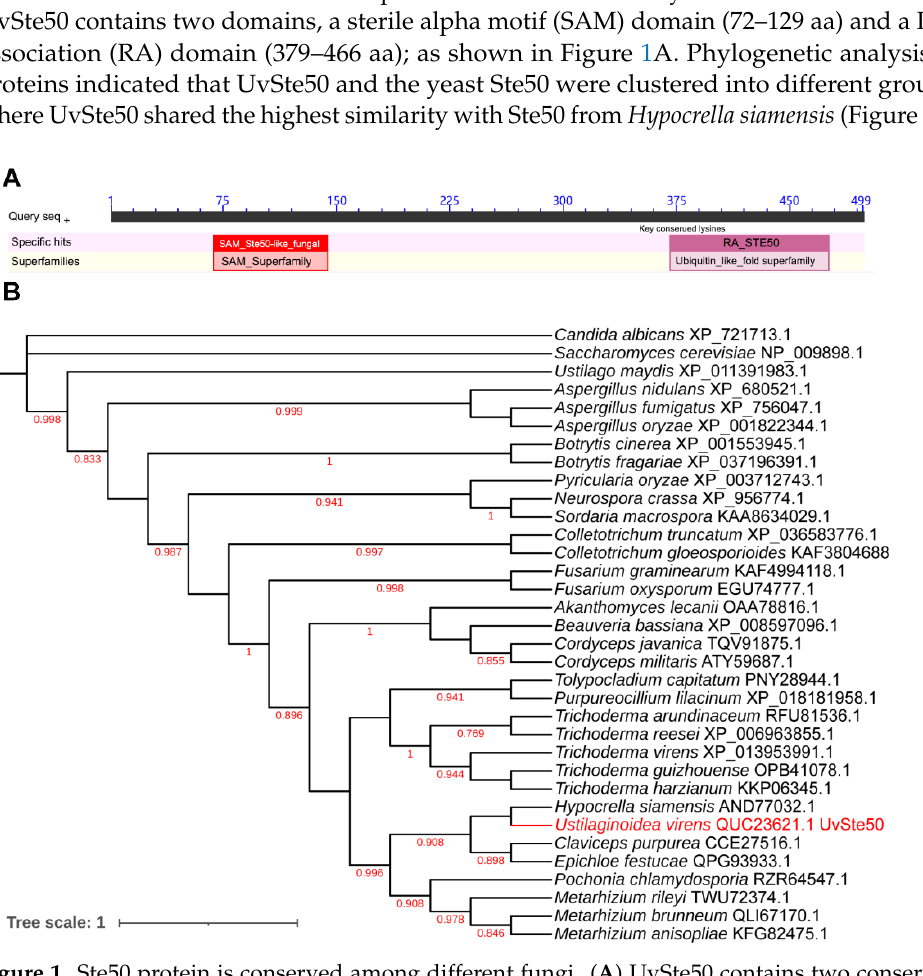
Figure 1. Ste50 protein is conserved among different fungi. ( A ) UvSte50 contains two conserved domains: a sterile alpha motif (SAM) domain (72–129 aa) and a Ras-association (RA) domain (379–466 aa). ( B ) The phylogenetic tree of fungal Ste50 orthologs. All sequences of Ste50 orthologs were downloaded from NCBI and their accession numbers are labeled on the right. The numbers indicate bootstrap